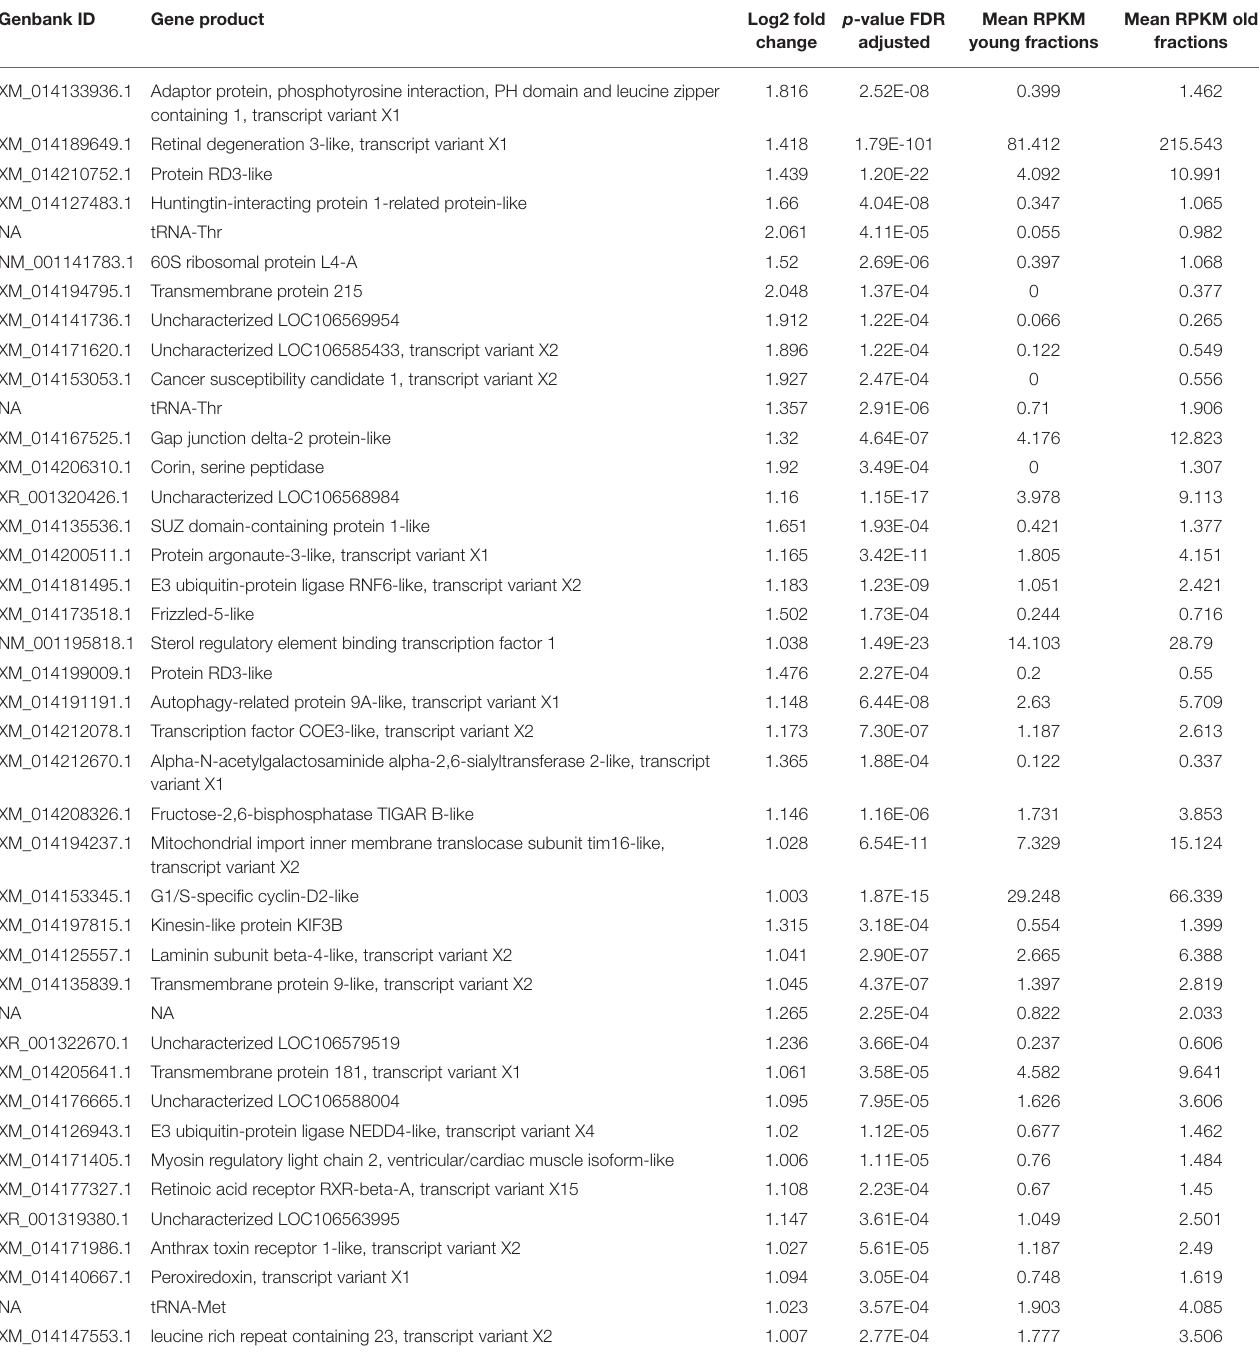
TABLE 2 | List of genes with significantly higher transcript levels in old vs. young erythrocyte fractions. Genbank